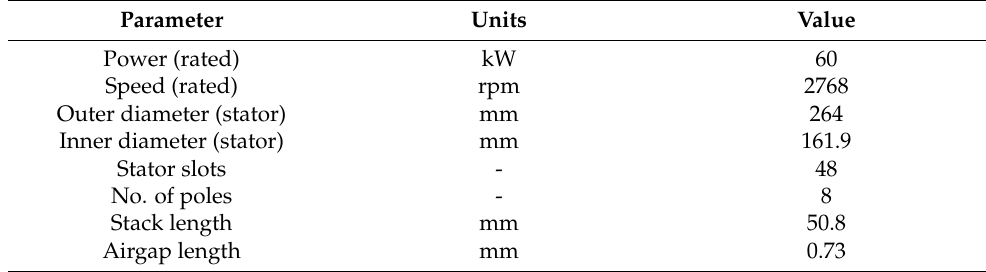
Figure 1. Basic model of machine layout: ( a ) Single layer distributed wound stator; ( b ) Rotor configuration with eight-pole field winding. Table 1. Major machine model parameters.